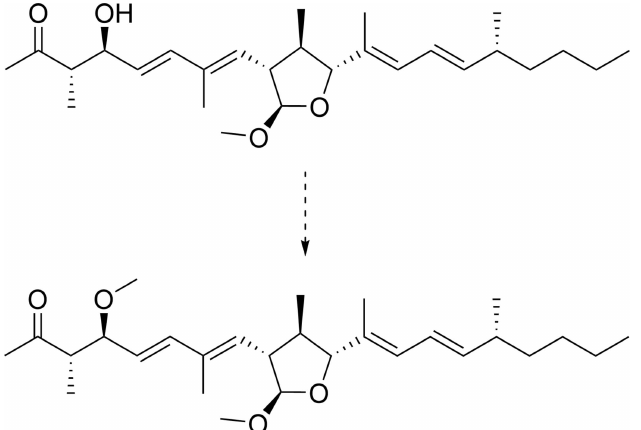
Figure 2 Methylation of O -desmethylfusaequisin A.